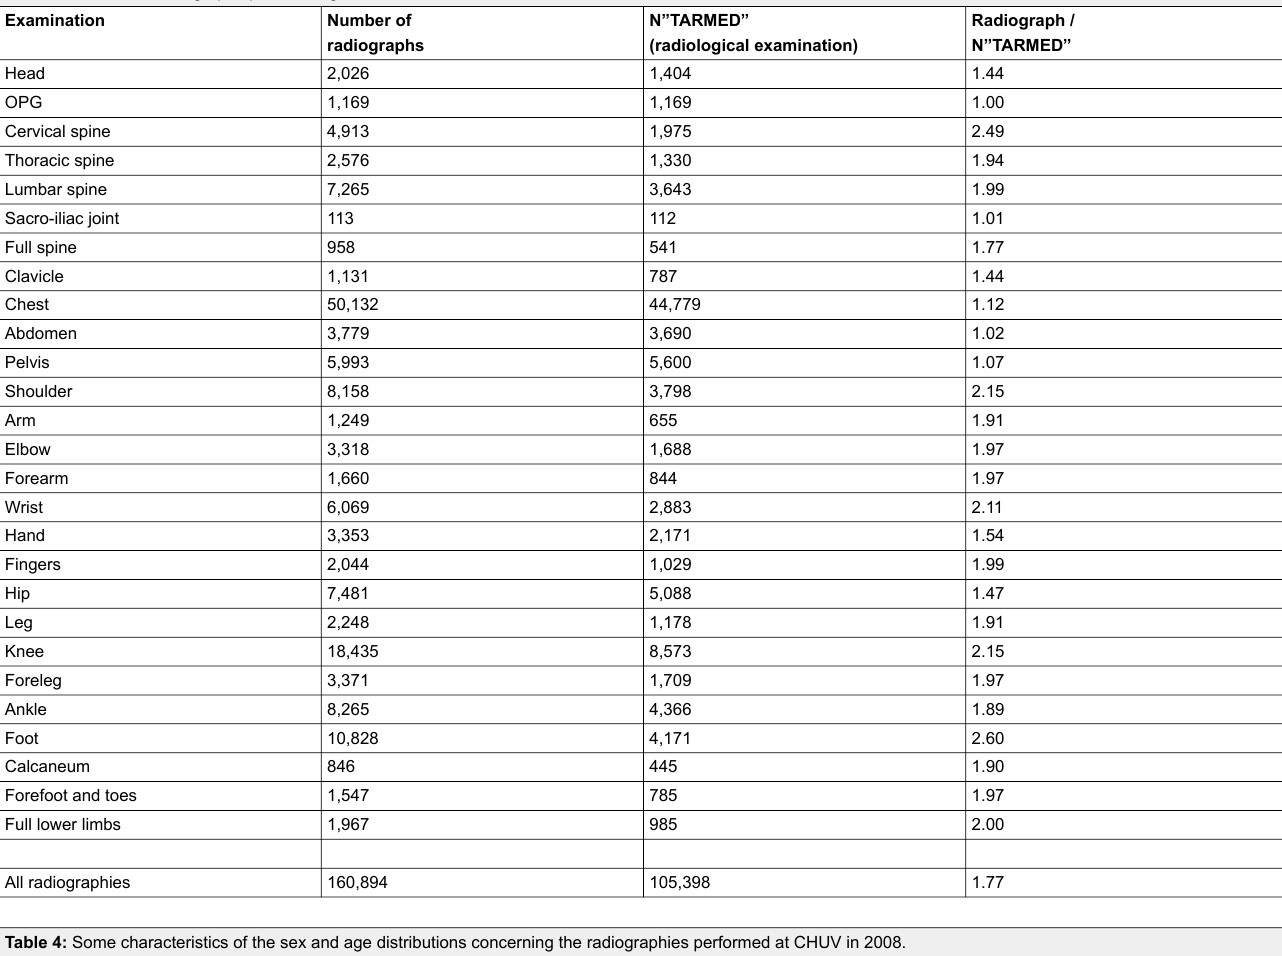
Table 3: Number of radiographs per radiological examination at CHUV.